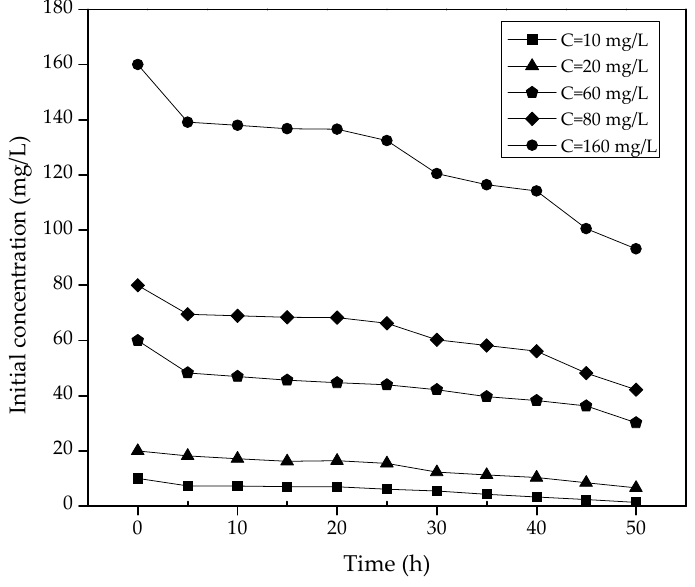
Figure 6. Profile of the degradation of acetaminophen followed by HPLC (catalyst mass = 1gr/L, rotational speed = 54 rpm, radiation of λ = 254 nm, number of lamps = 6, reaction volume= 12 L, maximum reaction time = 50 h).